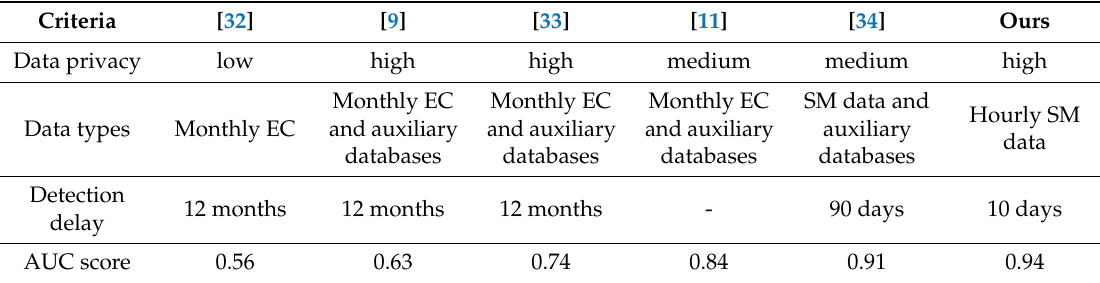
Table 6. Comparison with the state-of-the-art